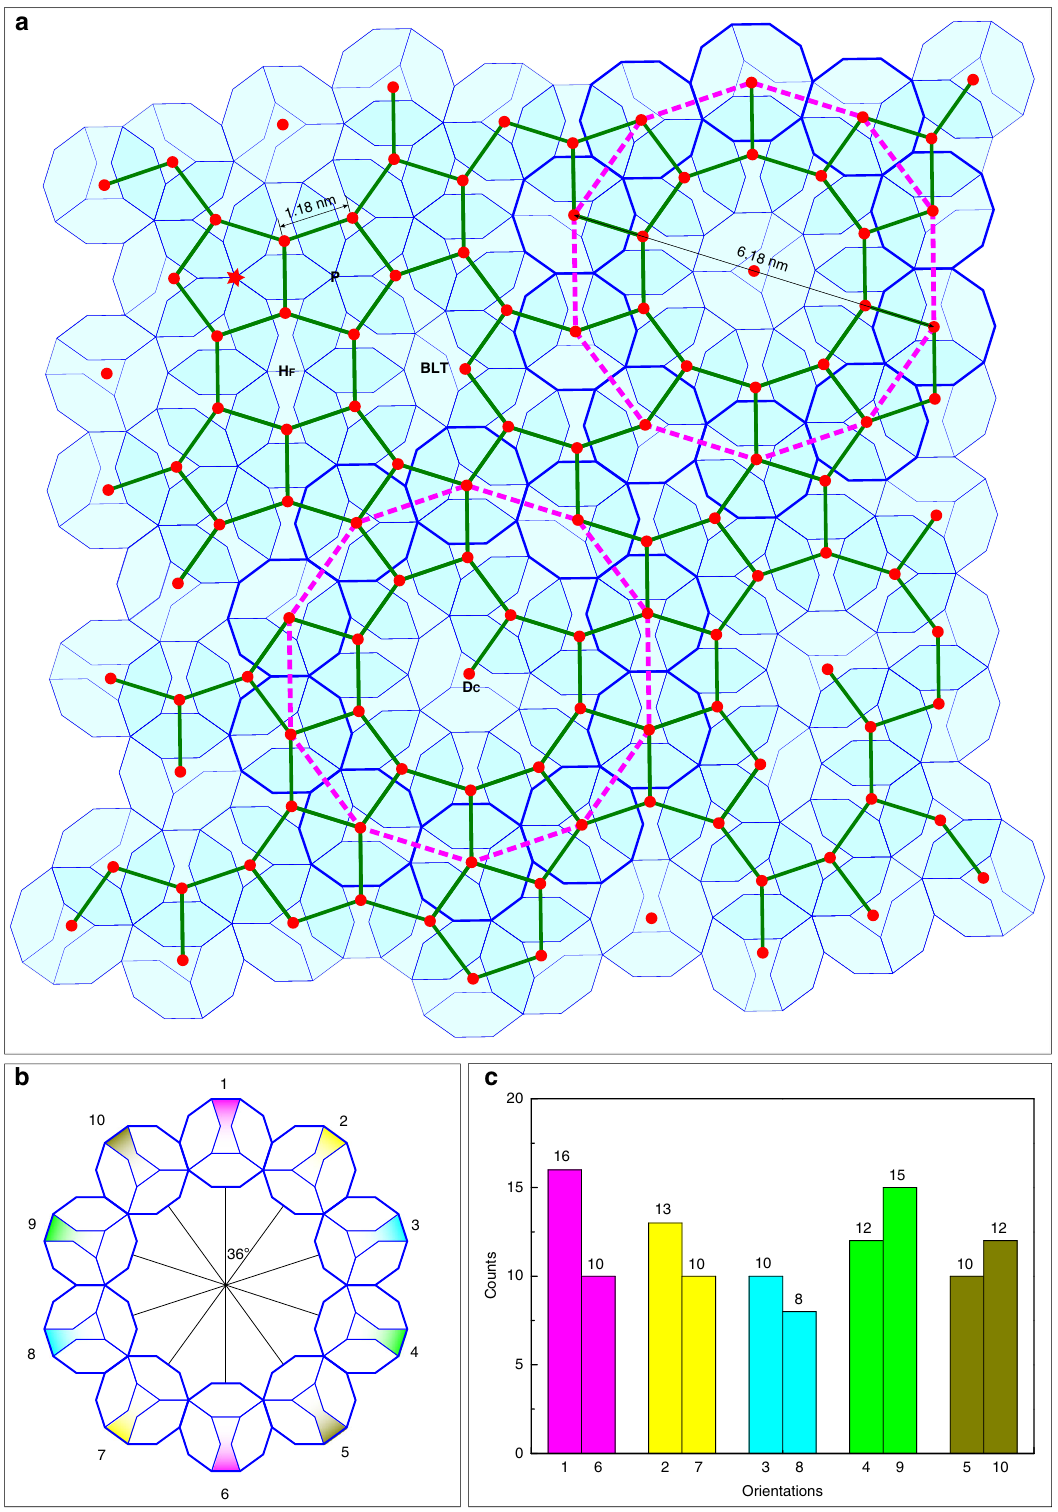
Fig. 4 Creation of a tiling by linking the centers of overlapping Lück decagons. In case of a Gummelt-decagon covering a P1-PT would result, what is not the case here. a The set of structural tiles contains regular pentagons (P), large decagons, fat hexagons ( H F ), banana-like tiles (BLT), and concave decagons ( D C ). The large purple dotted decagons (6.18nm in diameter) correspond to the large shaded decagons in Fig. 2d. b The ten orientations of the Lück decagons observed in a . c Corresponding histogram of decagon counts along each orientation. The average count of decagons along each direction is